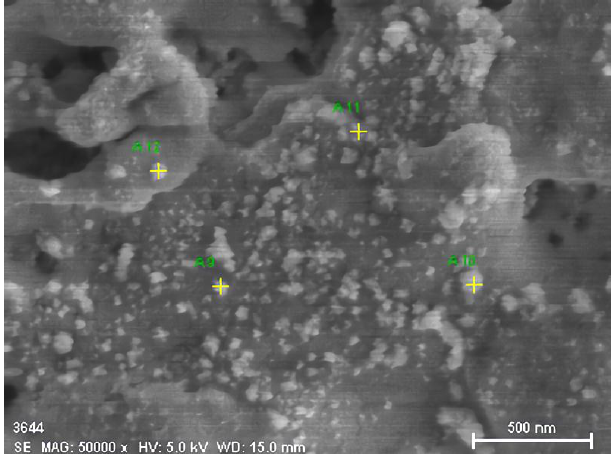
Figure 3. Composition analysis using the point method in EDS. Table 1. Composition analysis of surface particles treated by plasma electrolysis. Spectrum